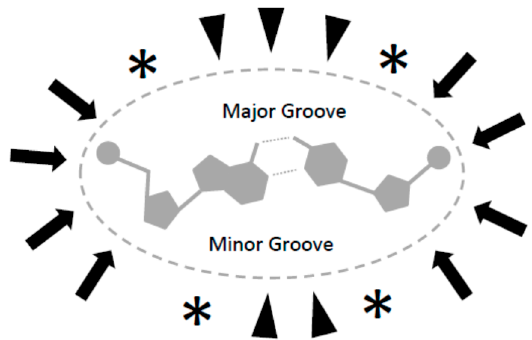
Figure 3. Cross section of a DNA molecule showing possible binding interactions with magnetic particles: electrostatic/ionic ( arrows ), hydrophobic ( stars ), and hydrogen donor/acceptors ( arrowheads